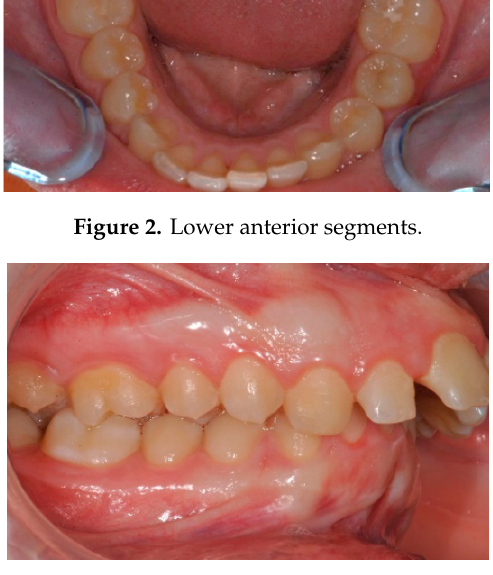
Figure 3. Right buccal segments